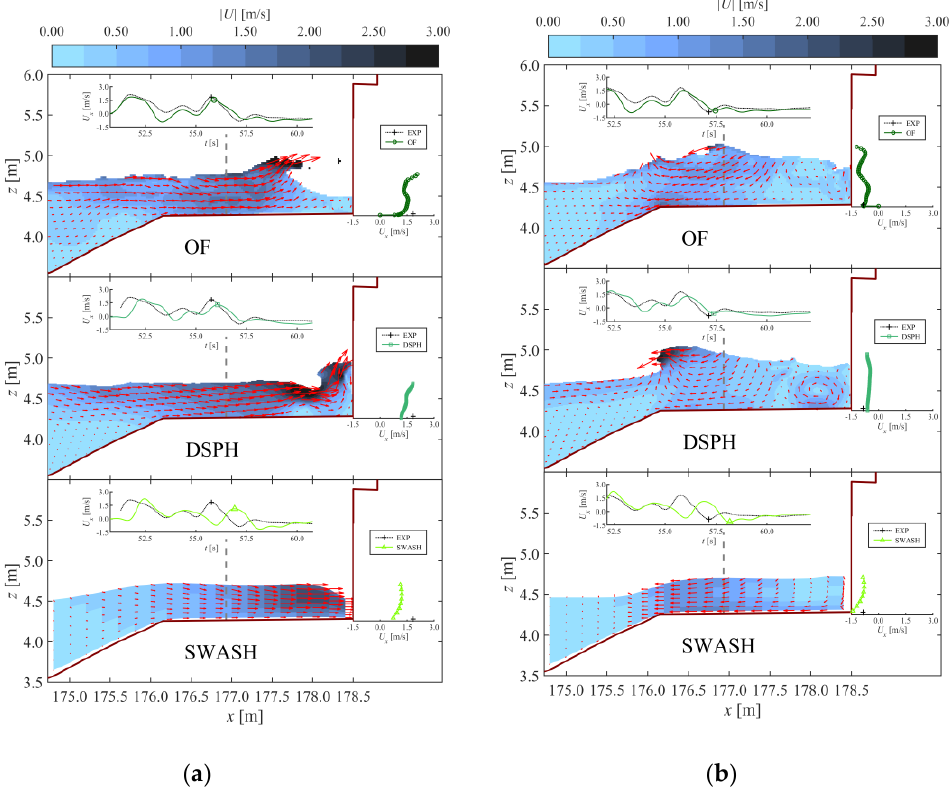
( a ) ( b ) Figure 17. Numerical comparative snapshots of the water flow on the dike. Colours are the velocity magnitude | U | according to the colour scale shown at the top of each figure. The red arrows are the velocity vectors, which are scaled for a clear visualisation. Each model snapshot has two inset graphs of U x at the ECM location on the promenade: at the top is a time series plot of U x in which a marker indicates the time of the snapshot, and next to the vertical wall the numerical U x -profile is plotted over the water column at the ECM location (vertical axis is z [m]) together with the single point U x measurement by the ECM (+marker). Adapted from the work in [3], with permission from the authors, 2020. ( a ) Time instant 2; ( b ) time instant 7. Table 5. Chronological list (in the EXP time frame) and description of the numerical model snapshots shown in Figures 15–17. Figure Description Figure 15a Dynamic F x peak of the small wave impact preceding the main bore impact. Local positive U x peak at the ECM location preceding the dynamic force Figure 17a peak of the main bore impact. Figure 15b Local F x peak preceding the dynamic force peak of the main bore impact. Figure 15c Dynamic F x peak of the main bore impact. Local F x minimum between the dynamic and quasi-static force peaks of the Figure 15d main bore impact. Figure 16a Quasi-static F x peak of the main bore impact. Local negative U x peak at the ECM location after the quasi-static force peak Figure 17b of the main bore impact. Figure 16b Local F x minimum after the quasi-static force peak of the main bore impact.